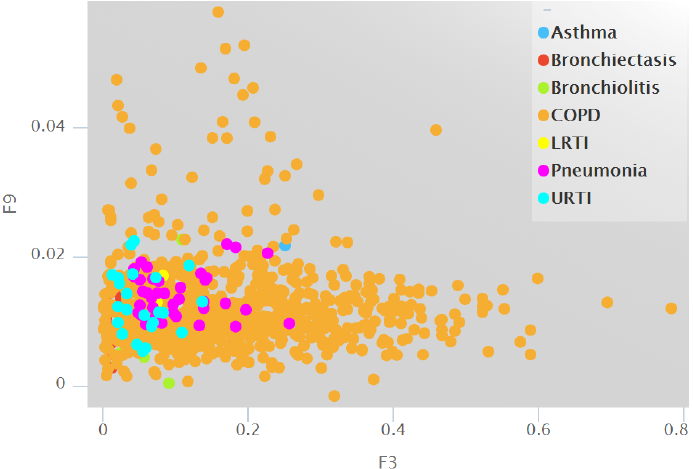
Figure 5. Scatterplot for the F 9 (i.e., Poly) and F 3 features (i.e., Spectral